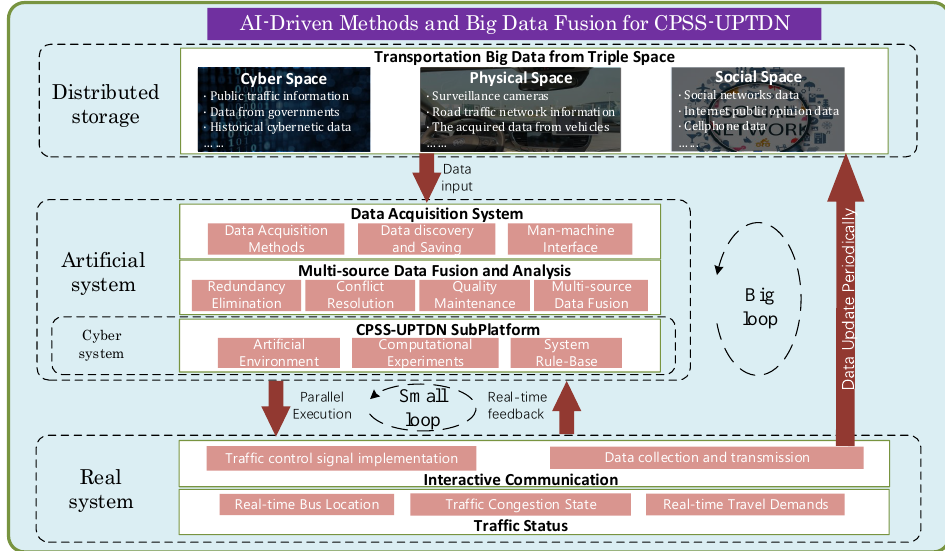
Figure 1. The proposed urban public traffic dynamic network based on the cyber-physical-social system (CPSS-UPTDN) is mainly composed of three modules and two